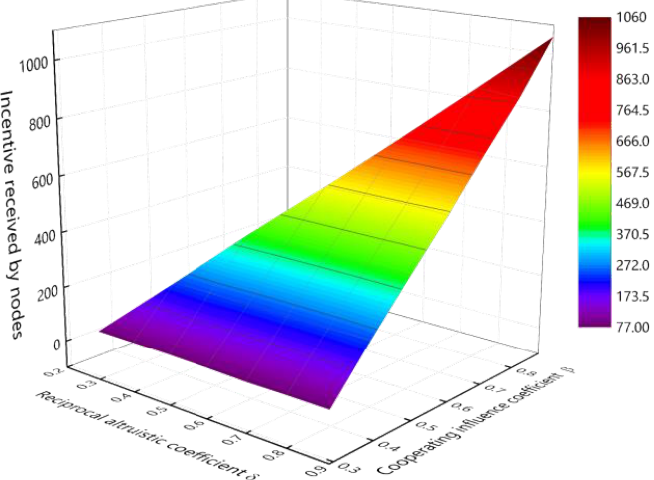
Figure 9. The impact of β on incentive received ratio ( µ = γ = 0.165, δ ∈ [ 0.1,0.9 ] , β ∈ ( 0,0.9 ) ).